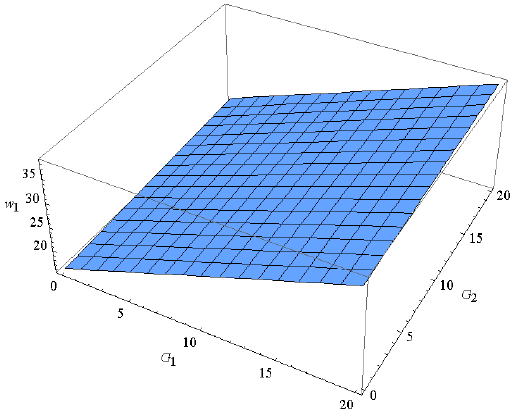
Figure 5. The impact of competitive product goodwill on the wholesale price of Product 1.